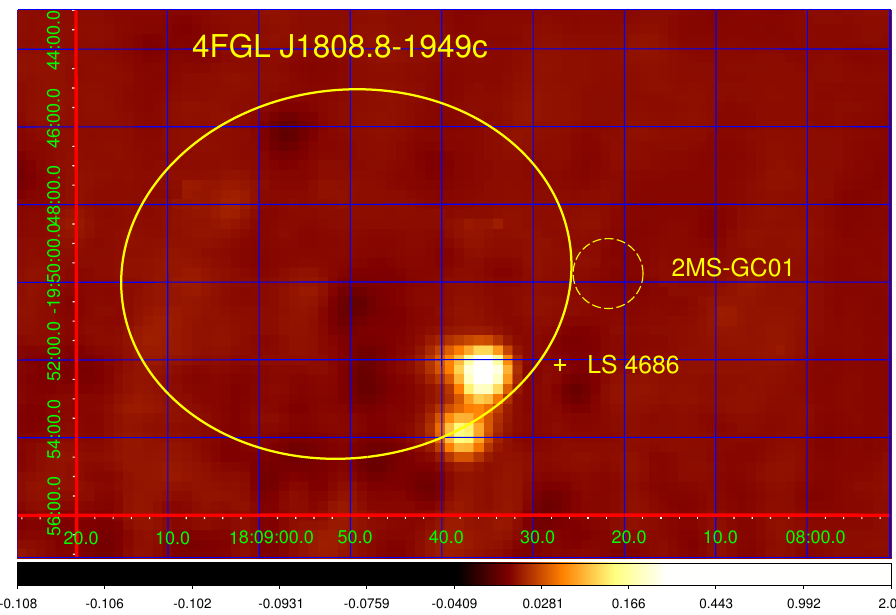
Figure 5. View of the 95% confidence ellipse of Fermi source 4FGL J1808.8-1949c plotted against the NRAO VLA Sky Survey image at the 20 cm wavelengths [27]. The brightest radio sources inside are of thermal nature. The small cross marks the LS 4686 location; the dashed circle represents the globular cluster 2MASS-GC01 in the field. Red axes display J2000.0 equatorial coordinates and the horizontal scale indicates the radio brightness scale in Jy beam − 1 .